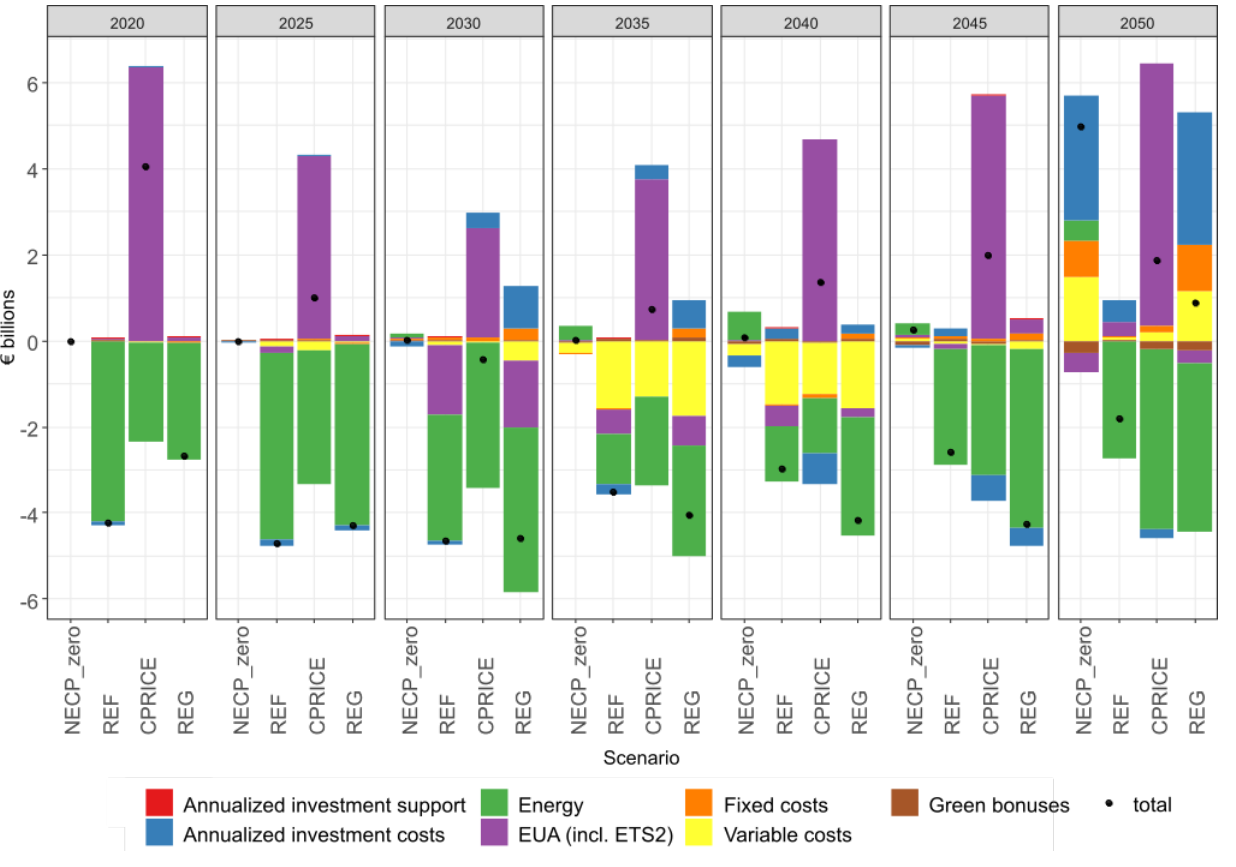
Figure 13. Annualized system cost — difference from NECP.